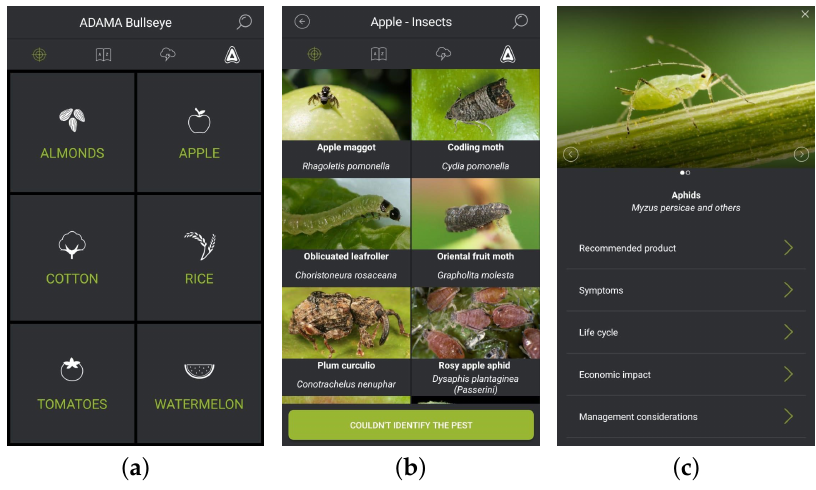
Figure 5. ADAMA Bullseye: ( a ) Main menu; ( b ) Pests of a particular crop; ( c ) Information about a particular